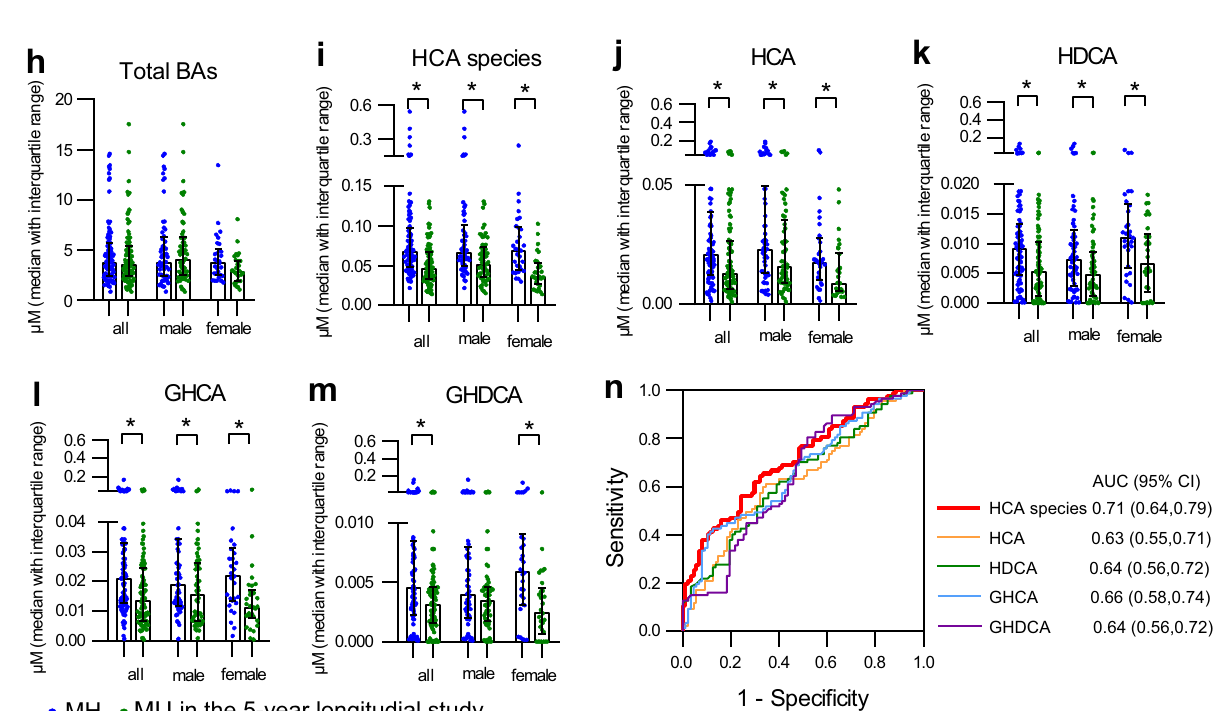
Fig. 4 Performances of HCA species in the 10-year and 5-year longitudinal studies. In the 10-year longitudinal study, a – f total BAs, total and individual HCA species in the serum of matched all ( n = 92), male ( n = 20), and female ( n = 72) individuals in future metabolically healthy (MH) ( n = 46) and metabolically unhealthy (MU) ( n = 46) groups. g ROC analyses of total and individual HCA species for the metabolic health longitudinal study. HCA species is the concentration summation of HCA, HDCA, GHCA, and GHDCA. In the 5-year longitudinal study, h – m total BAs, total and individual HCA species in the serum of matched all ( n = 174), male ( n = 114), and female ( n = 60) individuals in future MH ( n = 87) and MU ( n = 87) groups. n ROC analyses of total and individual HCA species for the metabolic health longitudinal study. HCA species is the concentration summation of HCA, HDCA, GHCA, GHDCA, THCA, and THDCA. Data are expressed as median with interquartile range ( a – f , h – m ). *indicates statistical signi fi cance ( p < 0.05) based on two-sided Mann – Whitney U test when comparing MH and